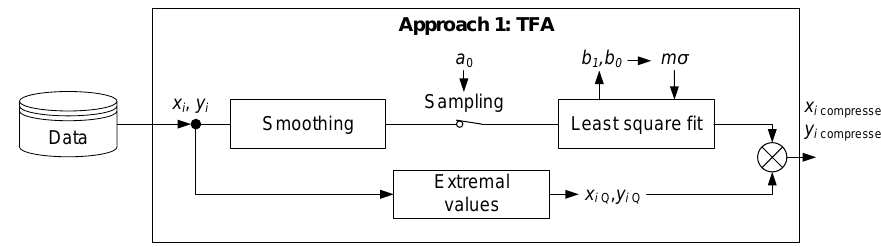
Figure 2. General process from uncompressed to compressed